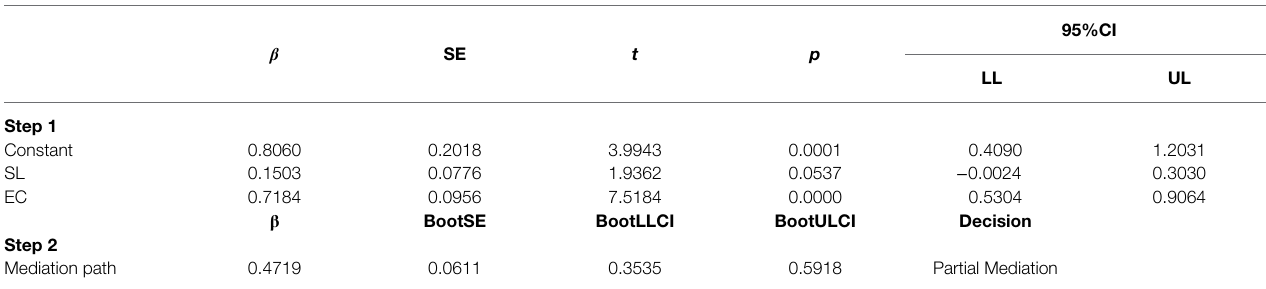
TABLE 5 | Mediation